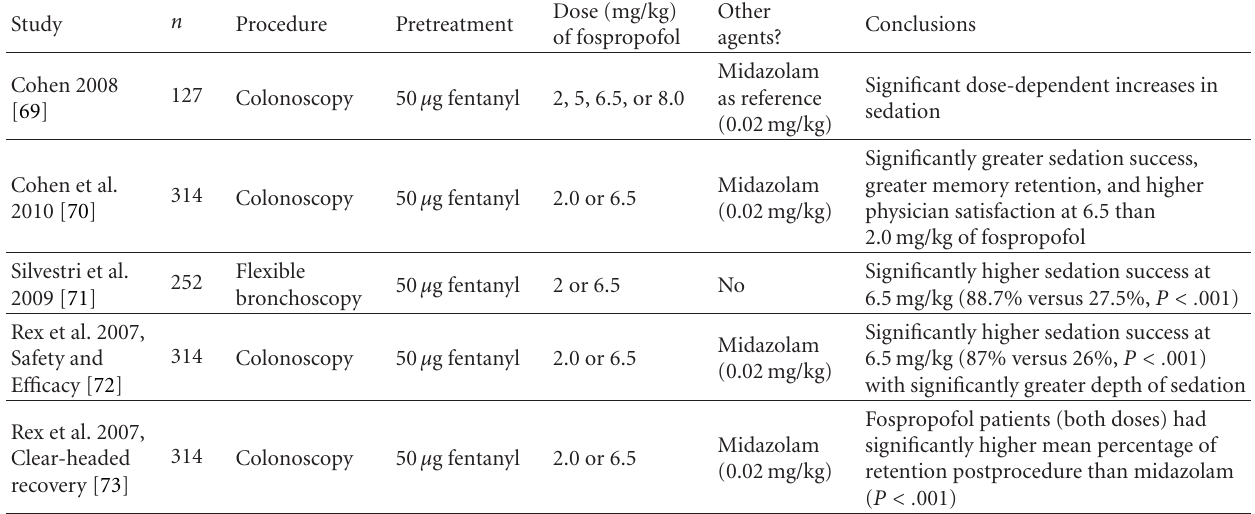
Table 1: Key clinical trials evaluating the use of fospropofol as an agent in MAC